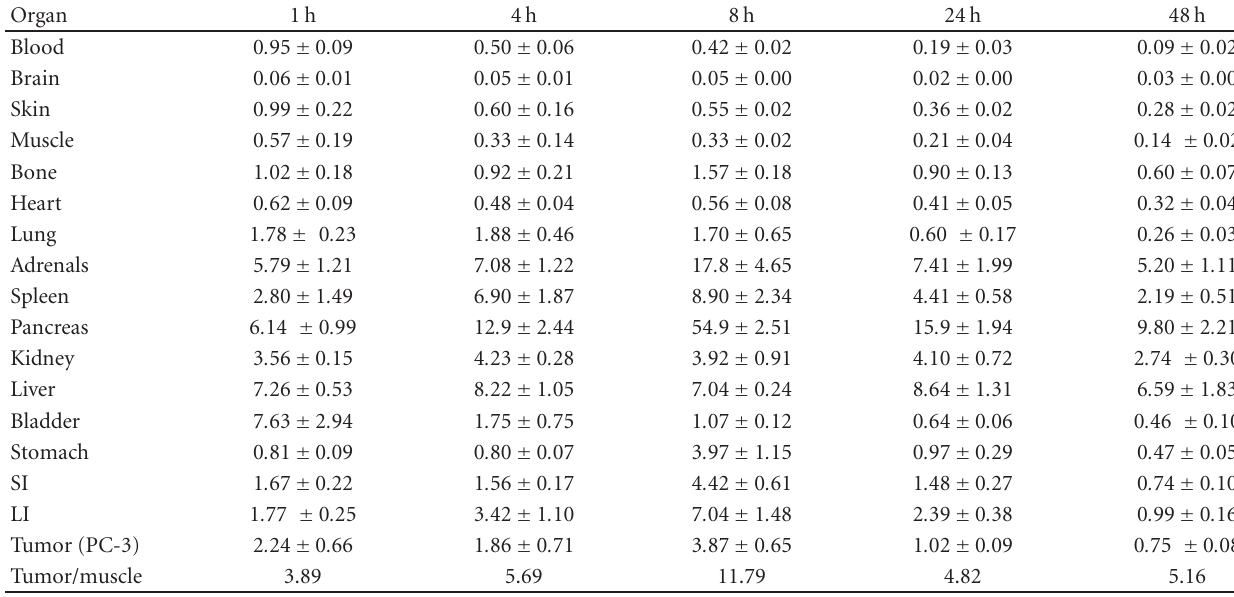
Table 1: Biodistribution of 111 In-AMBA after intravenous injection in PC-3 prostate tumor-bearing SCID